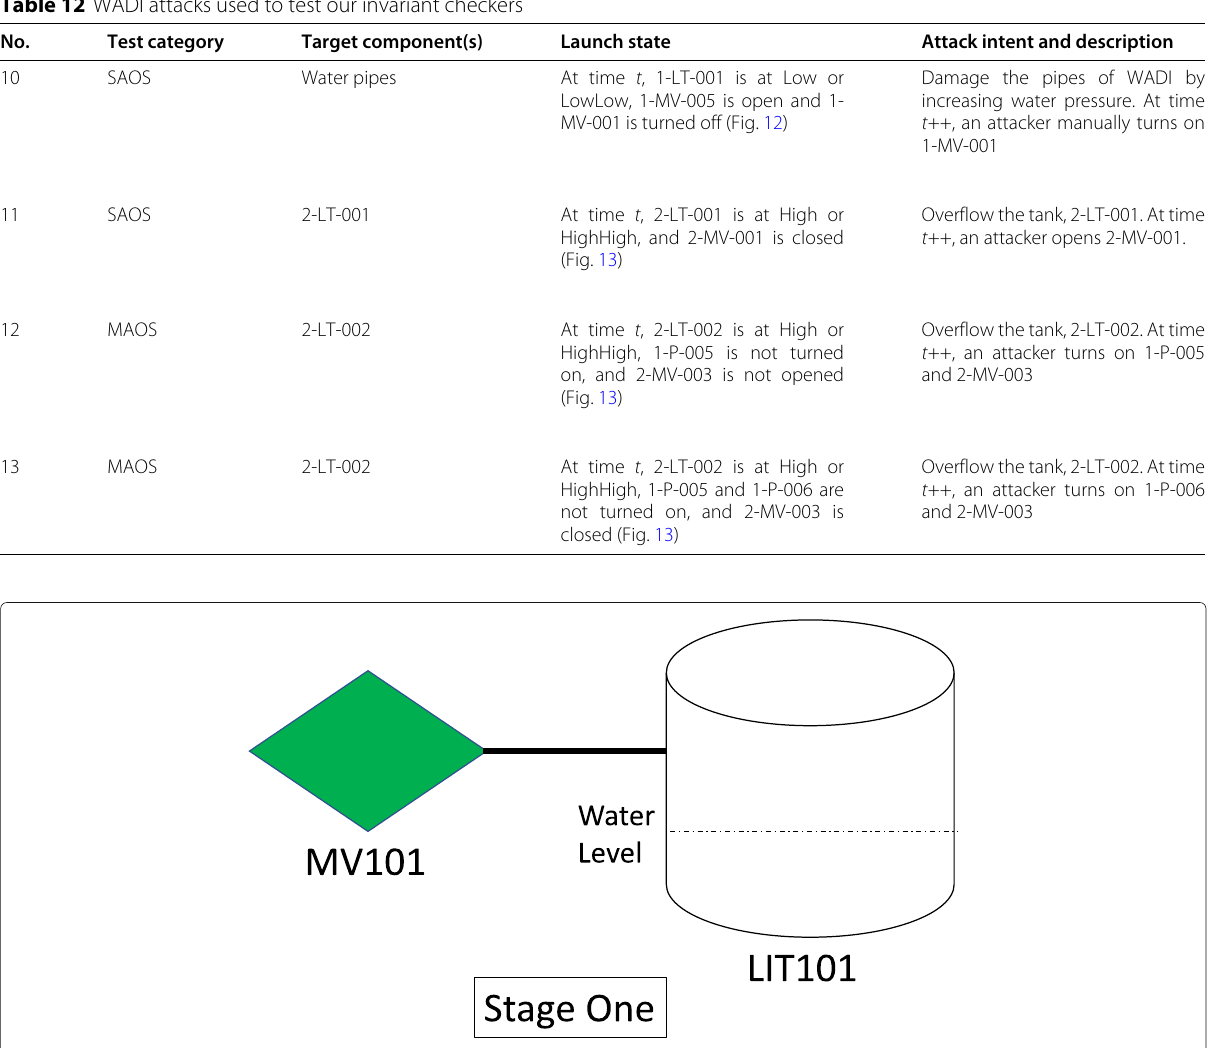
Table 12 WADI attacks used to test our invariant checkers